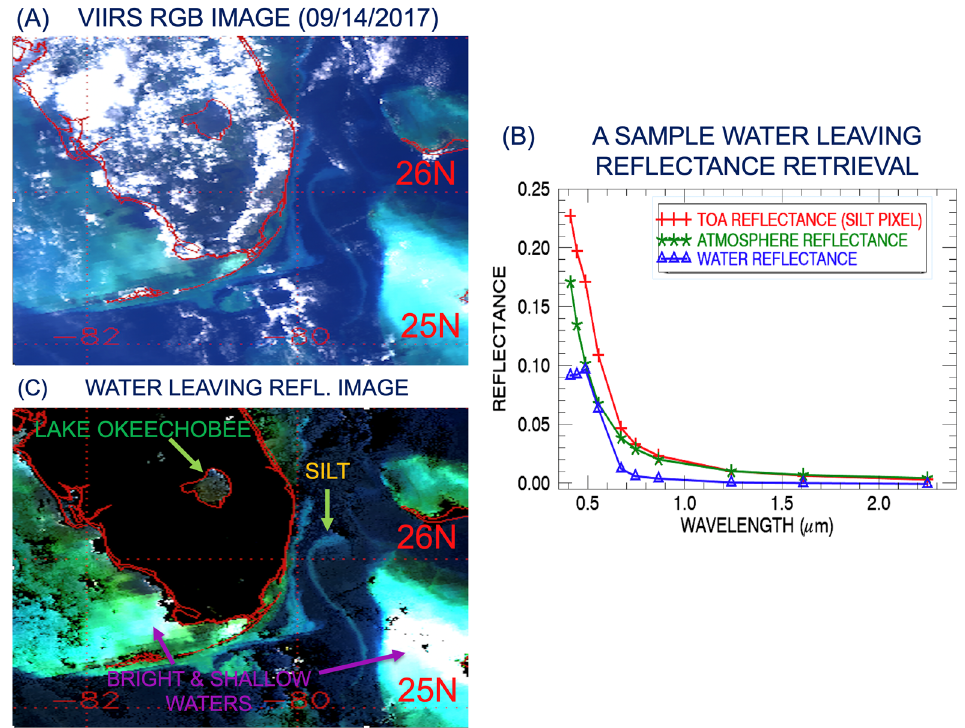
Figure 3. ( A )—a portion of VIIRS RGB image in southern Florida and nearby areas; ( B )—spectral plots illustrating our spectrum-matching process; and ( C )—the RGB image processed from our retrieved water leaving reflectance data.